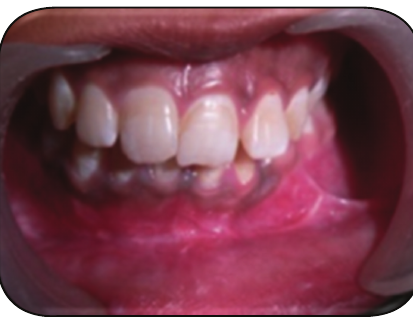
Figure 11: Postoperative photograph.